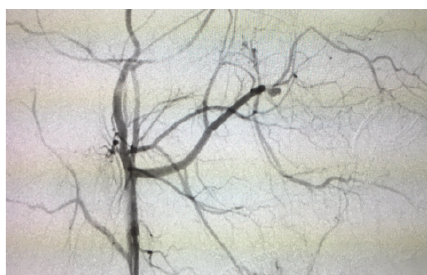
Figure 2: The diagnostic catheter evidences a dissecting posttrau- matic pseudoaneurysm of the medium-distal portion of the internal maxillary artery.